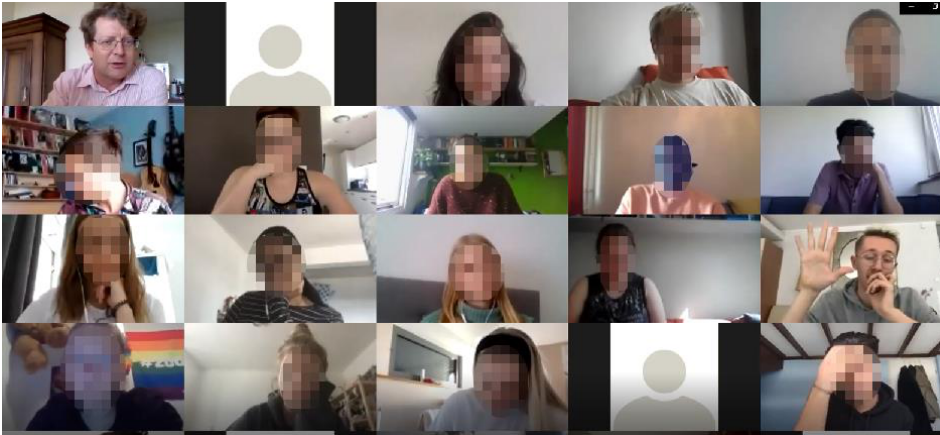
Figure 2. Visual representation of participant behaviors 2.